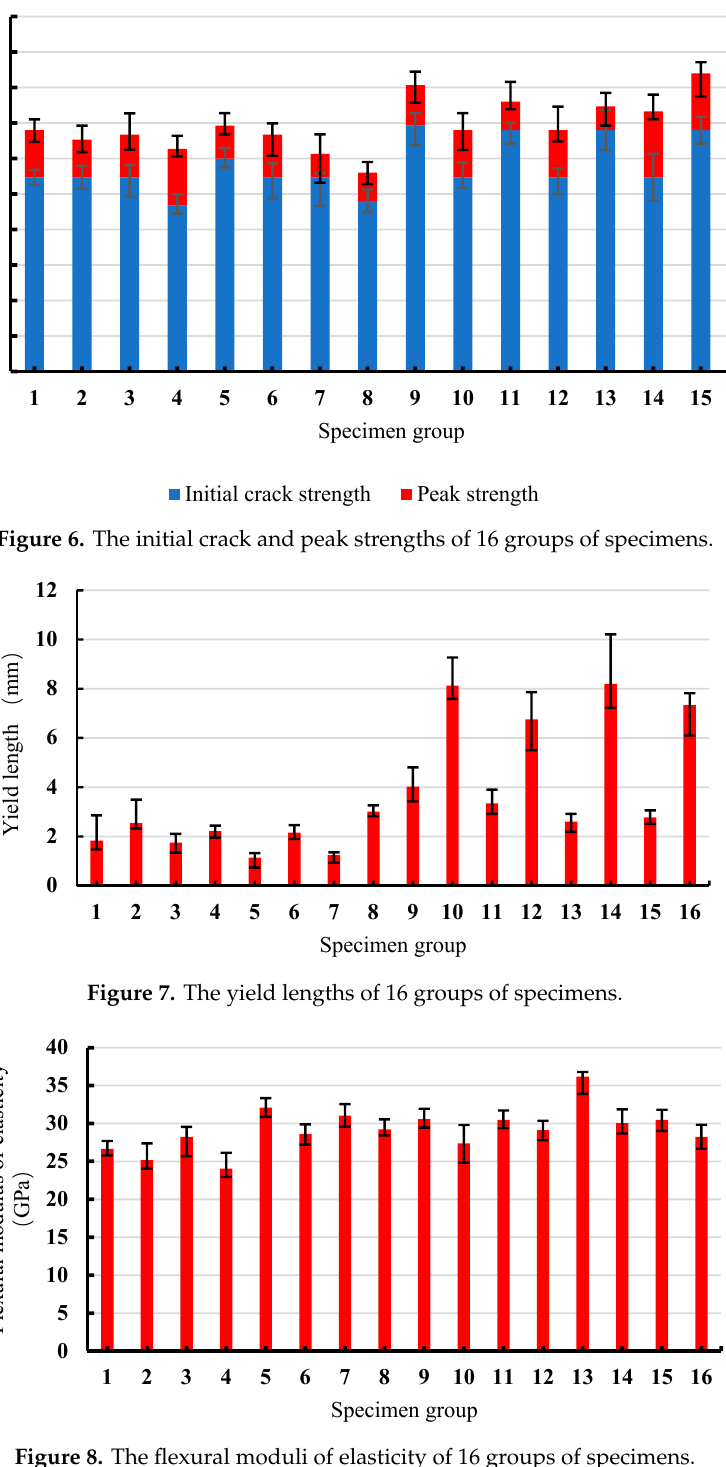
Figure 8. The flexural moduli of elasticity of 16 groups of specimens.